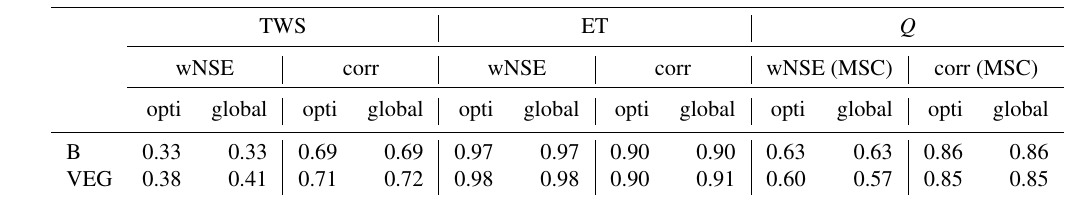
Table 3. Overall model performance metrics in terms of weighted Nash–Sutcliffe efficiency (wNSE) and Pearson’s correlation coefficient (corr) of total water storage (TWS), evapotranspiration (ET), and runoff ( Q ) in B and VEG experiments for the calibration subset (opti) and the entire study domain (global).